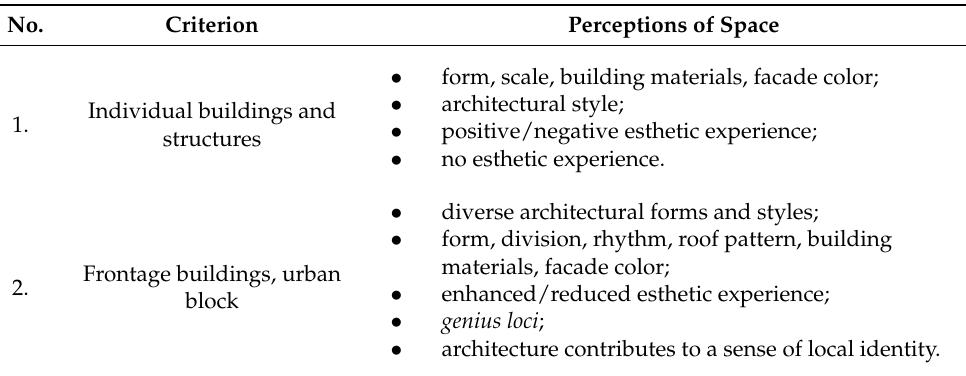
Table 6. The influence of architecture on perceptions of space.